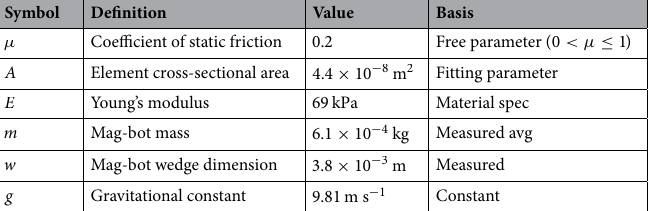
Table 1. Model parameters.